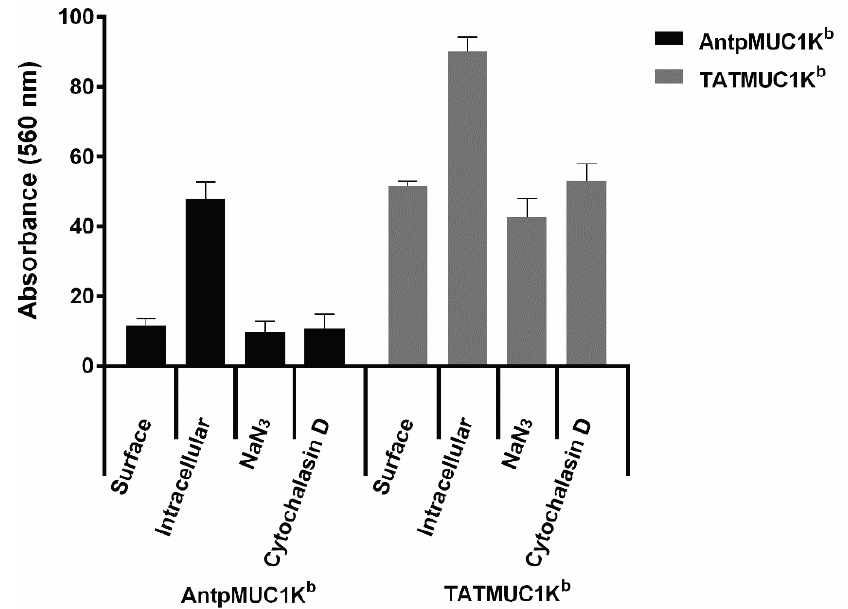
Figure 6. Uptake of AntpMUC1K b and TATMUC1K b by BMDC is via endocytosis. DC cultures were pre-treated for 45 min with cytochalasin D (10 µg/mL) or NaN 3 /2-deoxyglucose (10 mM) before adding 100 µg/mL of AntpMUC1K b or TATMUC1K b for 60 min.